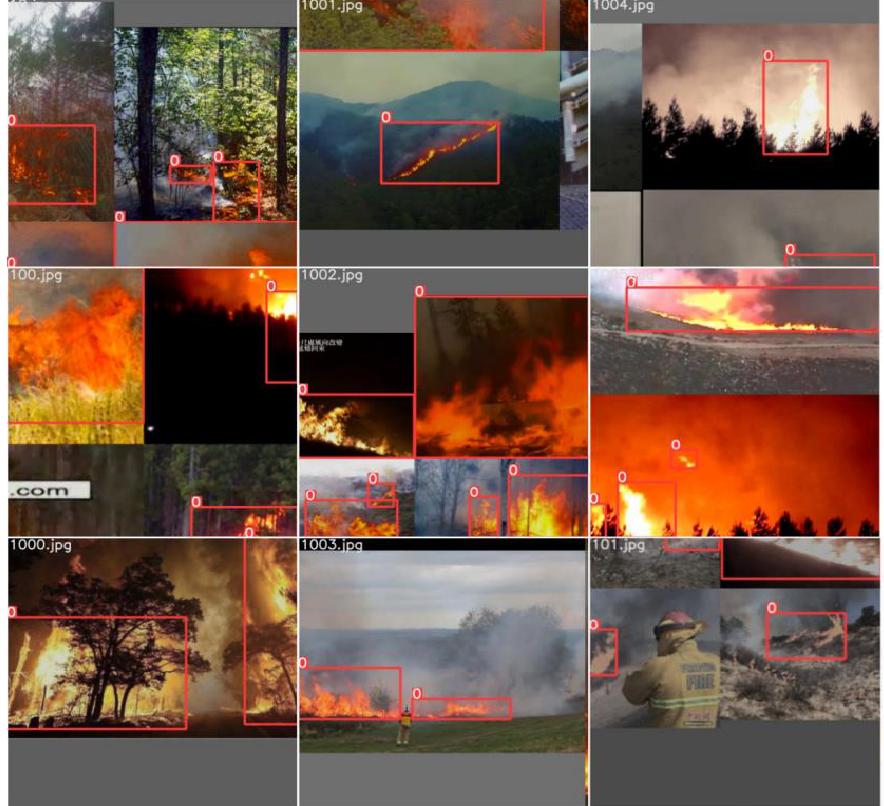
Figure 2. Schematic Diagram of Mosaic Online Enhancement Effect.